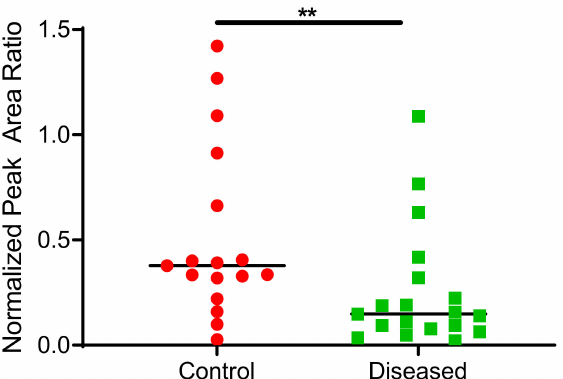
Figure 8. Total terfenadine metabolites (hydroxy + carboxy) formed in control and diseased cardiac tissue homogenates ( n = 17 for control tissue, n = 19 for diseased tissue). ** indicates p ≤